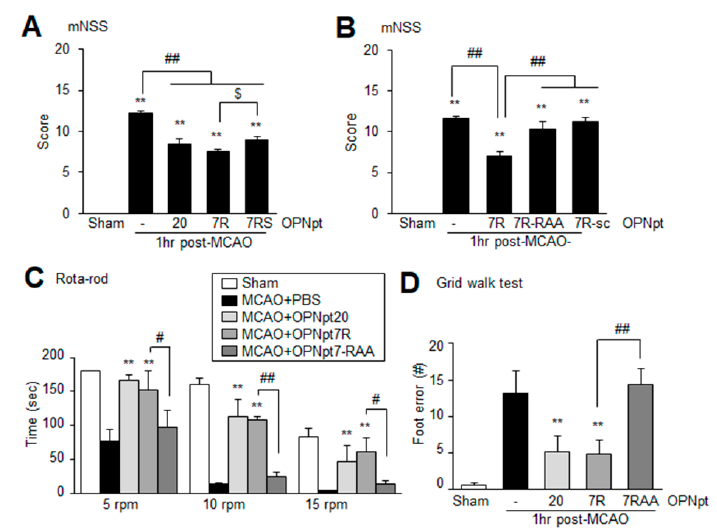
Figure 3. Recovery of neurological and motor deficits of MCAO rats by OPNpt7R; ( A , B ) OPNpt20 (500 ng), OPNpt7R (500 ng), OPNpt7RS (500 ng), OPNpt7R-RAA (500 ng), OPNpt7R-RAD (500 ng), or OPNpt7R-sc (500 ng) was administered intranasally at 1 h post-MCAO ( A ), and